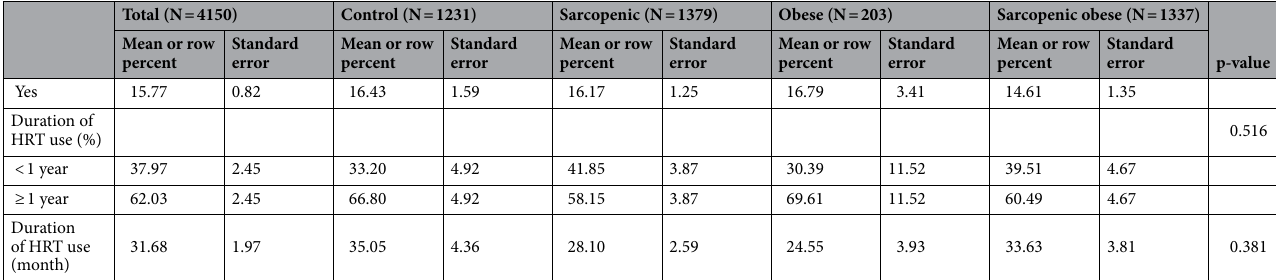
Table 1. Baseline clinical characteristics of all subjects. Sarcopenic: ASM index < 25.6%; Obese: BMI ≥ 25. Continuous variables were analyzed by one-way ANOVA and categorical variables were analyzed by Rao-